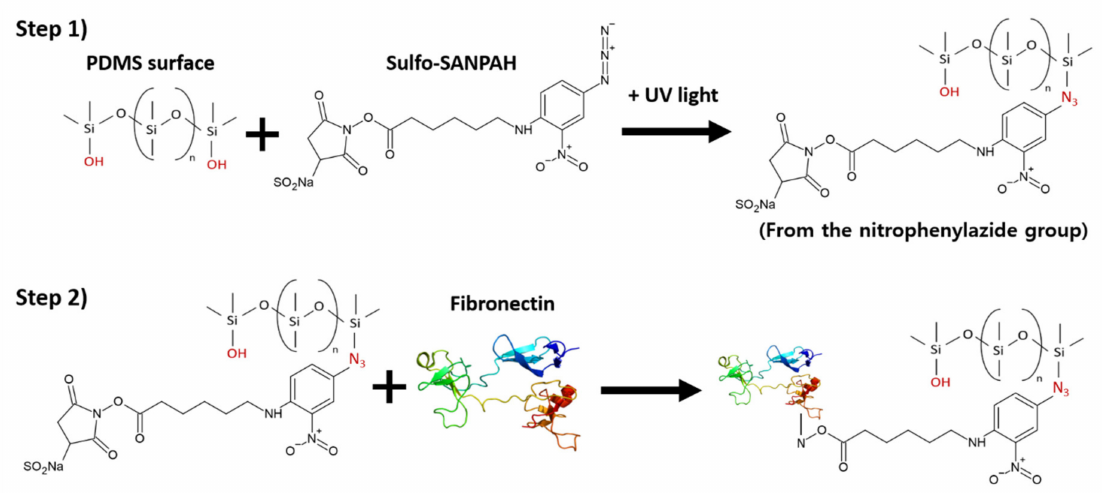
Figure 8. Chemical structures of the crosslinking agent Sulfo-SANPAH and the actual appearance of AD-HSE. Chemical reaction scheme using Sulfo-SANPAH. Sulfo-SANPAH is a heterobifunctional crosslinker containing an amine-reactive NHS ester and a photoactivatable nitrophenyl azide group. Crosslinking agent treatment sequence: ( Step 1 ) Sulfo-SANPAH is crosslinked to PDMS through a nitrophenyl azide group, and nitrene with high reactivity is formed from the nitrophenyl azide group during UV treatment, which is crosslinked by a double bond on the PDMS surface. ( Step 2 ) The UV-light-processed Sulfo-SANPAH is treated with fibronectin. After crosslinking of nitrene to the PDMS surface, binding to fibronectin forms a stronger crosslink. When the collagen solution comes into contact with the Sulfo-SANPAH-treated surface and gels, the collagen fibers are crosslinked on the PDMS surface through an open NHS